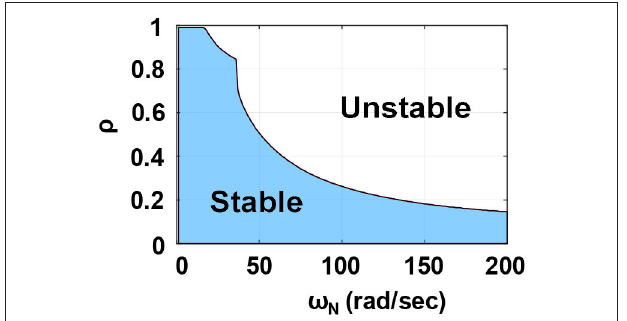
FIGURE 8 | Stable margin in terms of mass ratio for RTHS of BMD systems with perfect compensation.